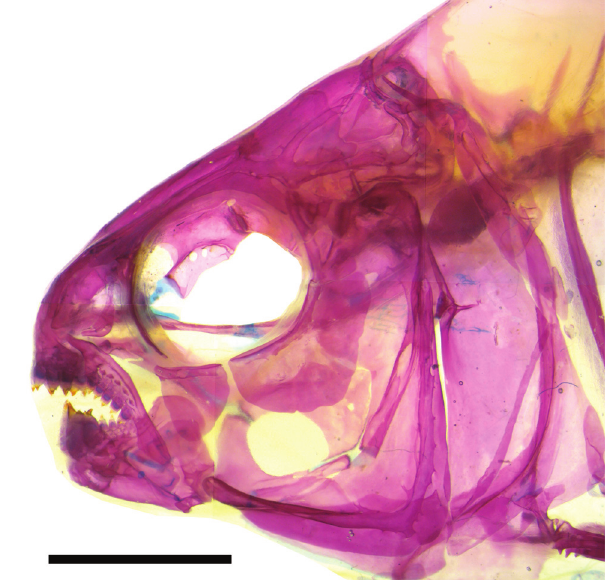
Fig. 5. Cranium and pectoral girdle of Carlastyanax aurocaudatus , CI-FML 5015, 44.4 mm SL, lateral view, anterior to left. Gill skeleton and right suspensorium removed. Scale bar = 5